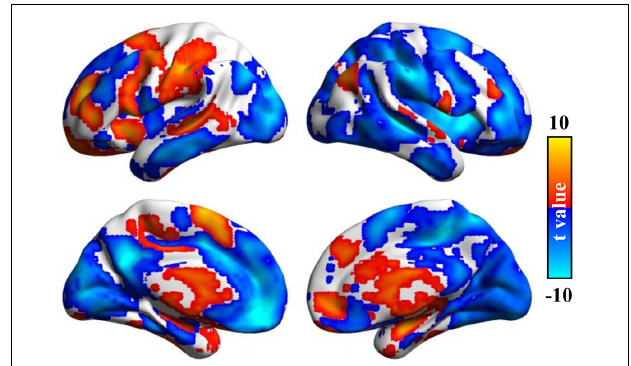
FIGURE 4 | Significant differences between Asso and functional connectivity strength (FCS). The paired t -test was used to identify the voxel-wise differences between Asso and FCS. Significant differences between Asso and FCS maps were found.